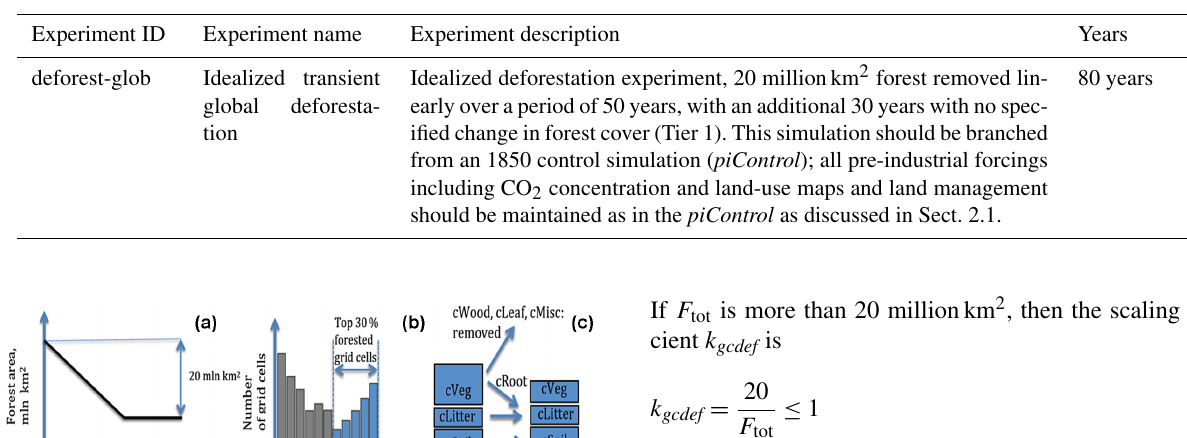
Table 1. Idealized deforestation experiment designed to gain process understanding and to assess biogeophysical role of land-cover change on climate and inter-compare modeled biogeochemical response to deforestation (concentration-driven).